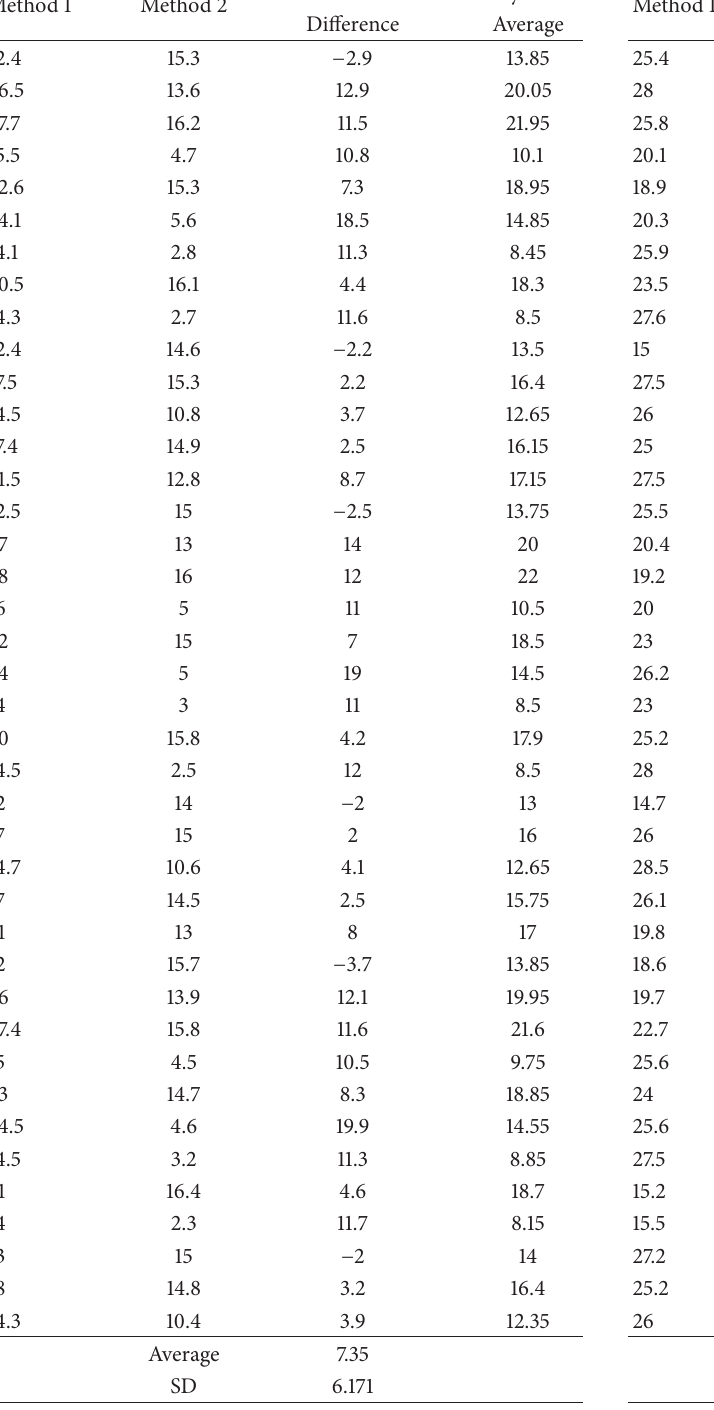
Table 3: Quarter S-N/I-T Bland-Altman analysis (see Figure 5). Method 1